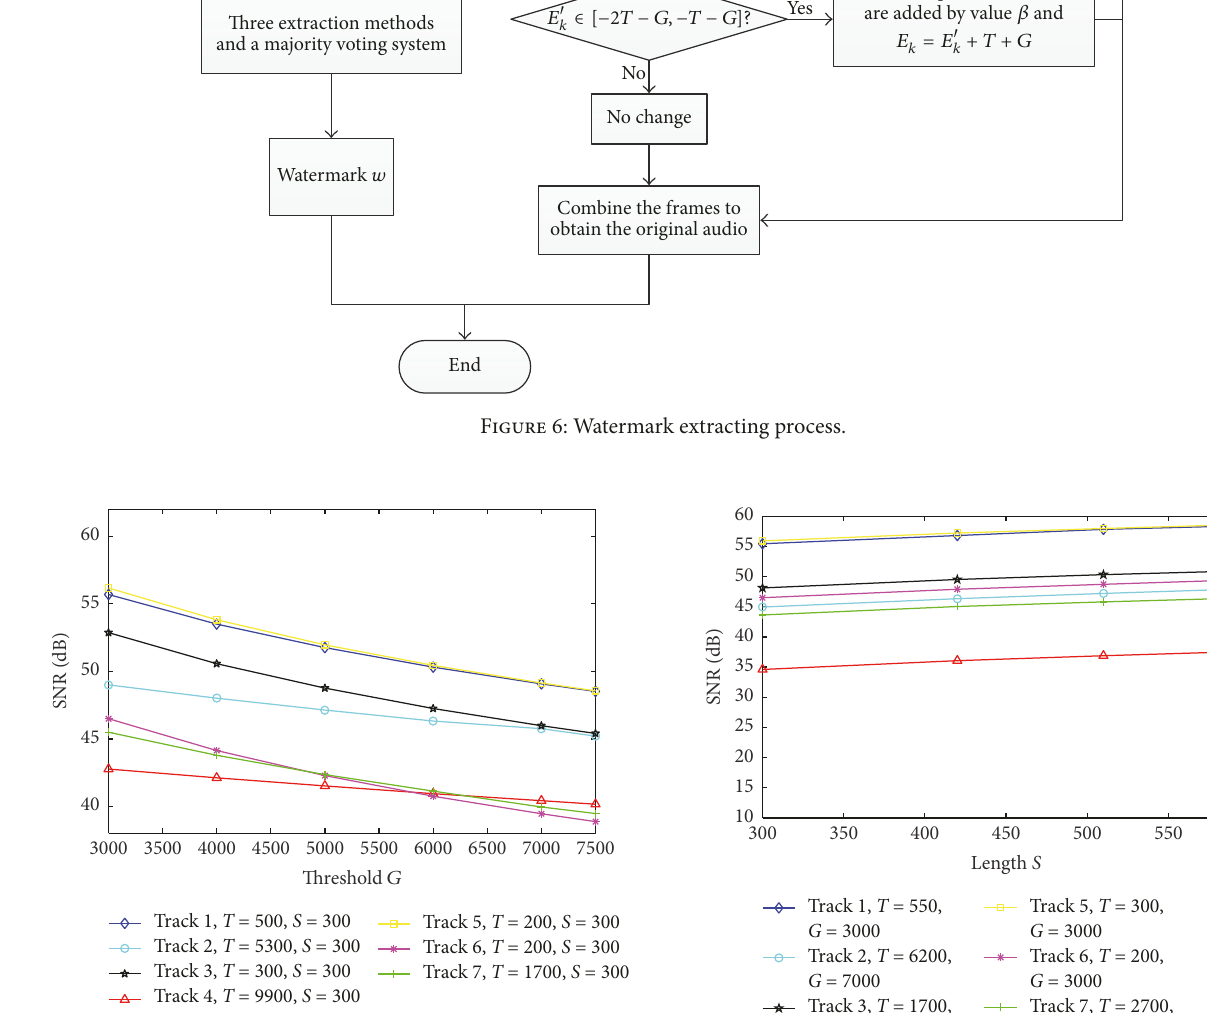
Figure 7: Relationship between SNR and threshold 𝐺 .